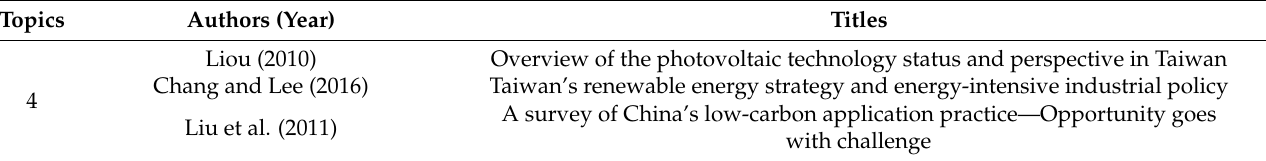
Table 8. Relevant documents with NSWK signal topics 1